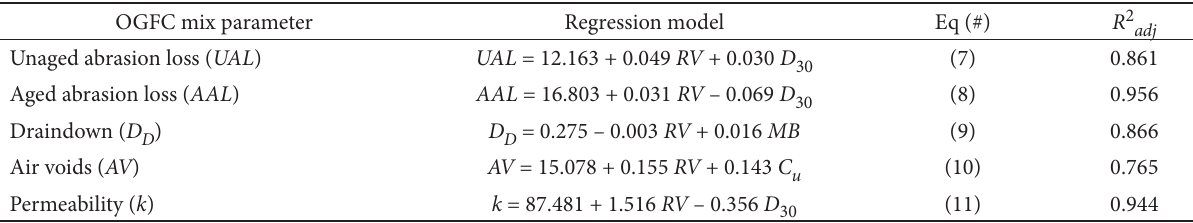
Table 8. Regression models for filler characteristics and OGFC mix parameters OGFC mix